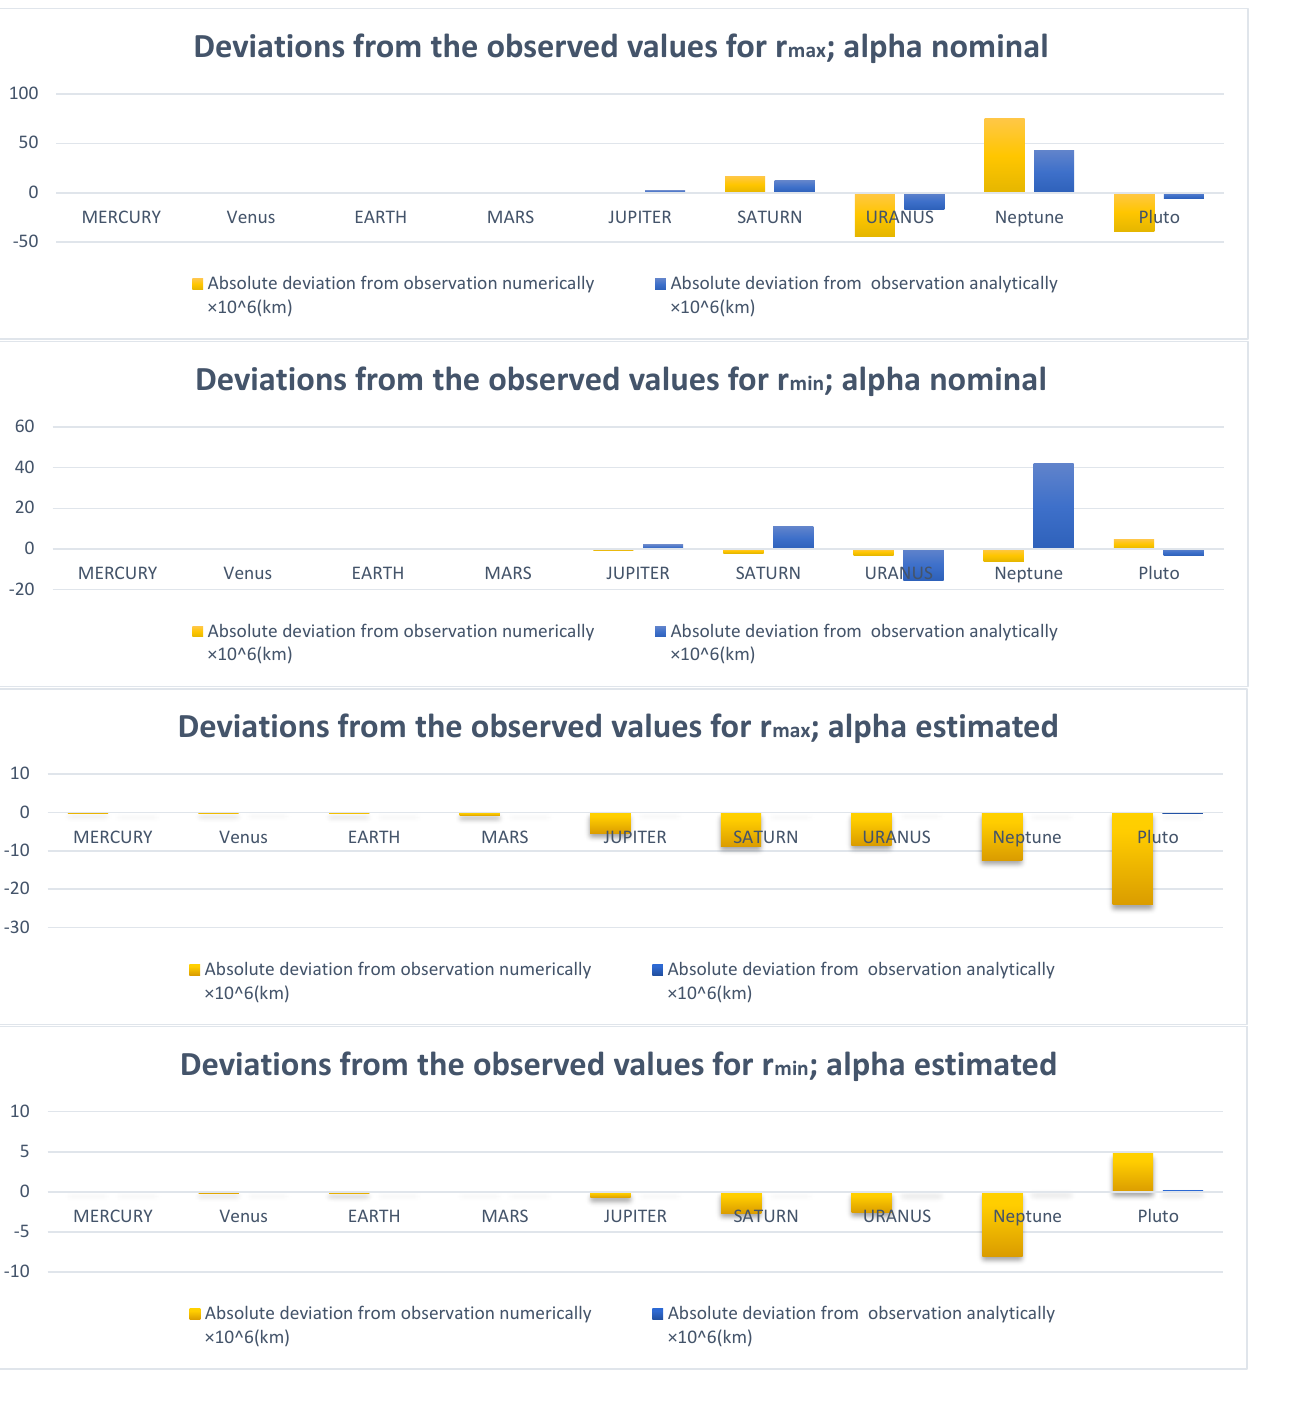
Figure 4. Absolute deviations from observed data for each planet according to the used method (numerical vs. analytical) and/or the Yukawa strength determination (nominal vs.